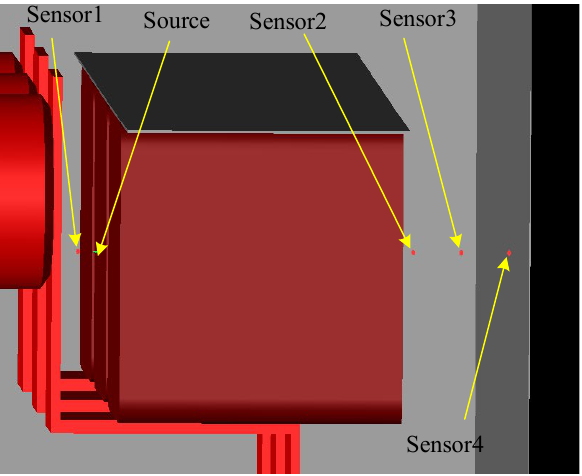
Figure 5. Location distribution of source and point sensors around current transformer .